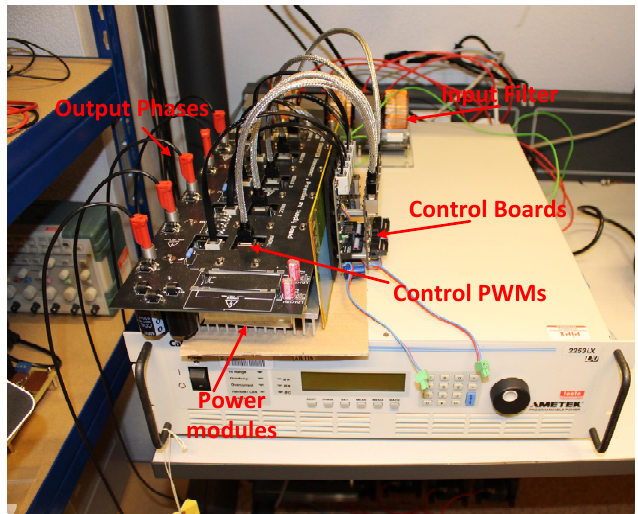
Figure 11. Prototype of the 3 × 5 matrix converter.